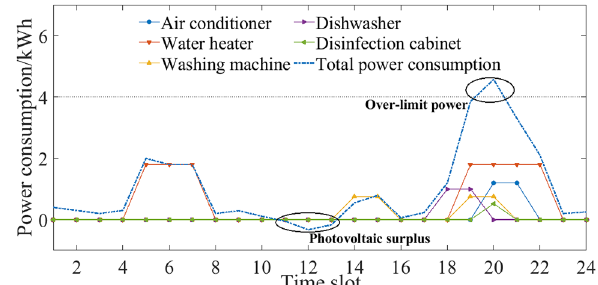
Figure 4. Original power consumption plan in winter.